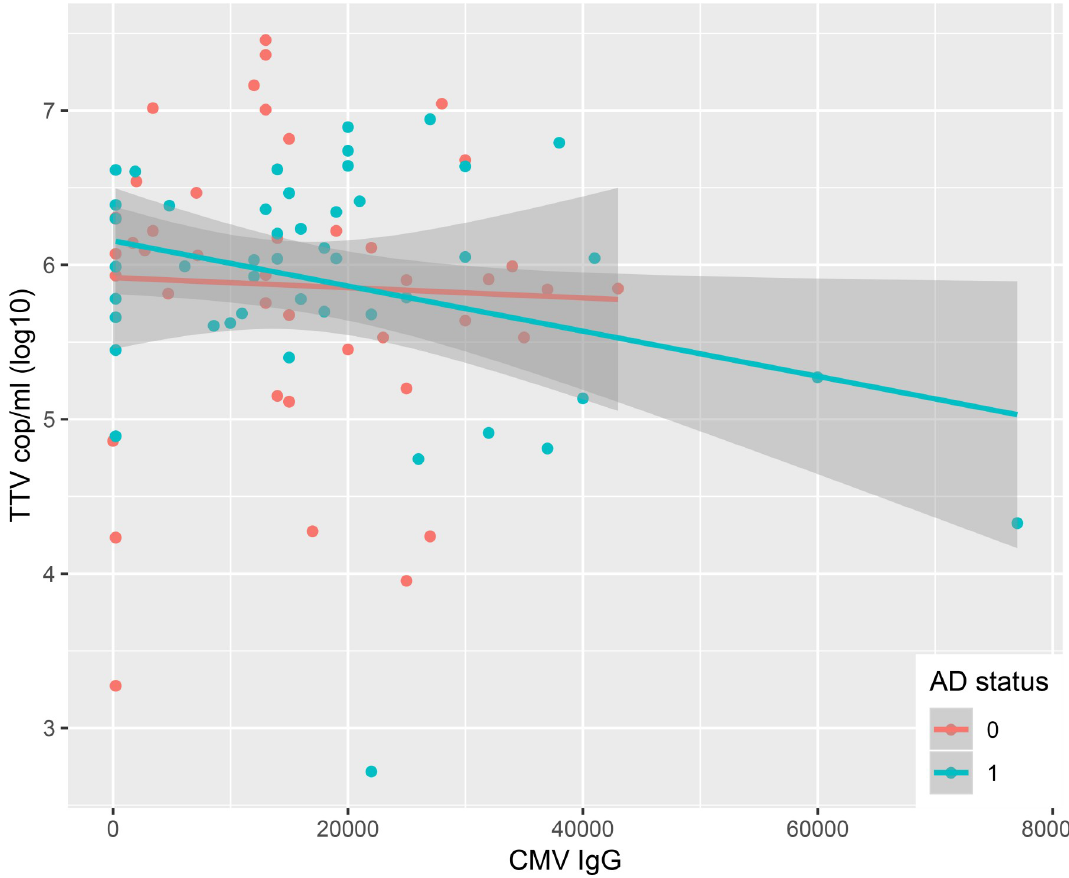
Fig 3. TTV viral load vs. CMV IgG. TTV viral load decreases with increasing CMV IgG. Alzheimer status coded in blue (AD) and red